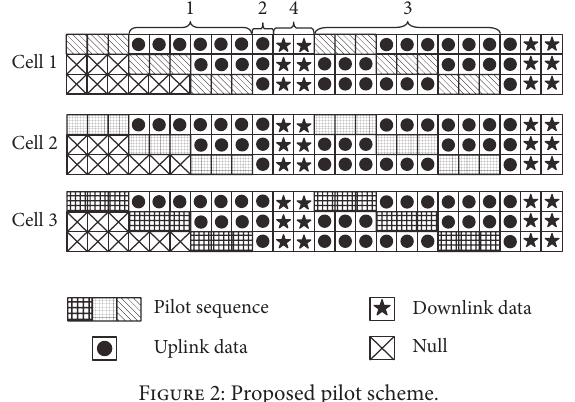
Figure 2: Proposed pilot